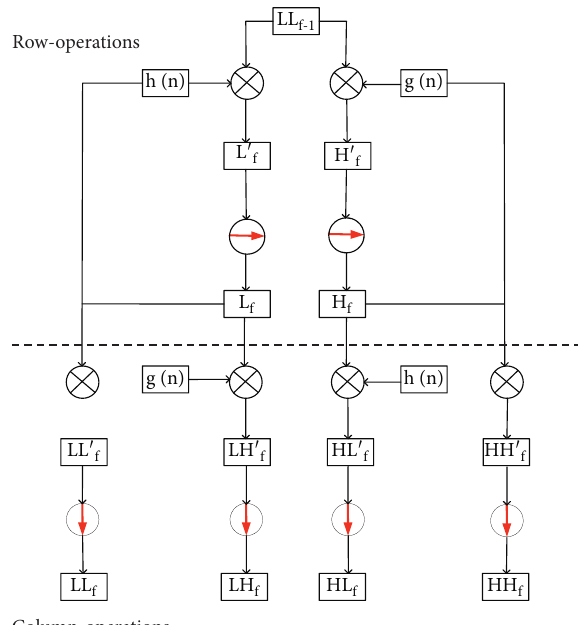
Figure 5: Image decomposition using 2D-DWT.